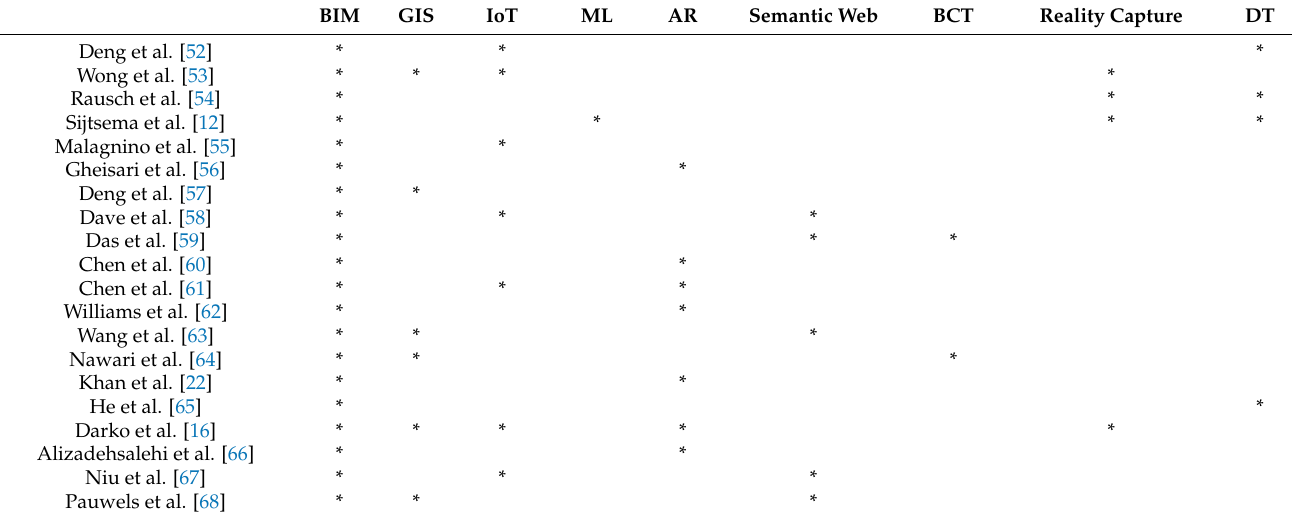
Table 3. List of papers referring to the integration of technologies in the FOCIT literature.